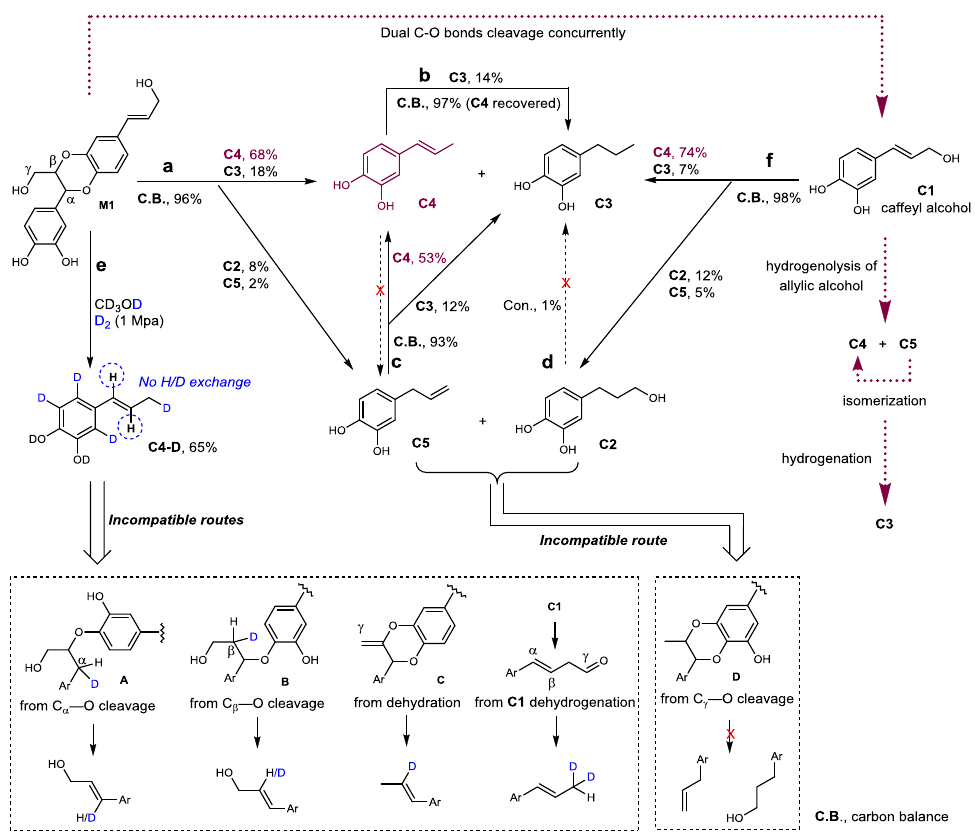
Fig. 5 Ru/ZnO/C-catalyzed hydrogenolysis of C-lignin model and catechols. Reaction conditions: substrate (50 mg), Ru/ZnO/C (10 mg, 20 wt%), MeOH (10 mL), 1 MPa H 2 , 4 h, unless otherwise noted. a M1 as substrate (reaction a). b C4 as substrate (reaction b). c C5 as substrate (reaction c). d C2 as substrate (reaction d). e Reaction in D 2 and CD 3 OD with M1 as substrate (reaction e), and other catechols were also generated. f C1 as substrate (reaction